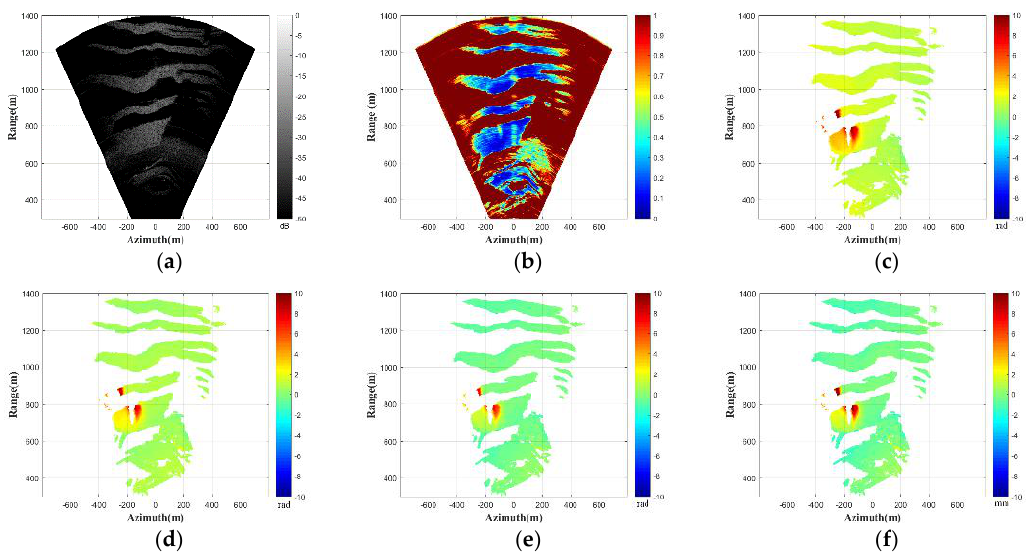
Figure 9. Experimental results: ( a ) reflectivity image; ( b ) sub-images entropy map; ( c ) uncorrected phase; ( d ) corrected phases using the linear model method; ( e ) corrected phase using proposed method; and ( f ) deformation map.